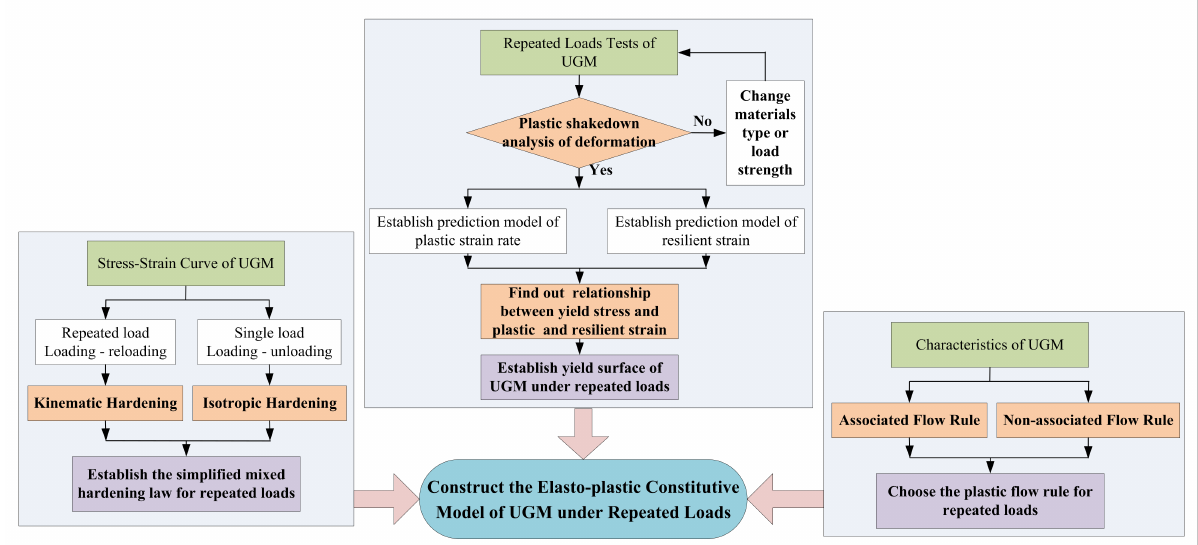
Figure 1. Flowchart of the construction of the revised SMP elasto-plastic constitutive